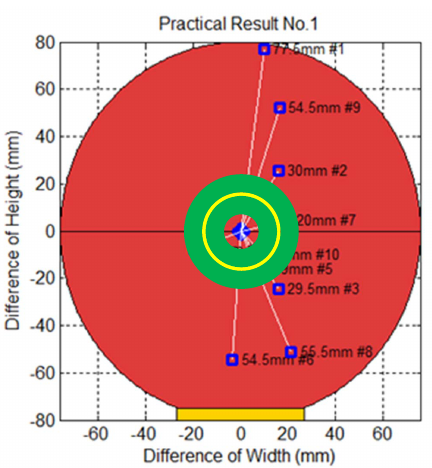
Figure 23. Striking accuracy with respect to the paddle area: the green area represents the area of striking error center with the mean (yellow) and a standard deviation.